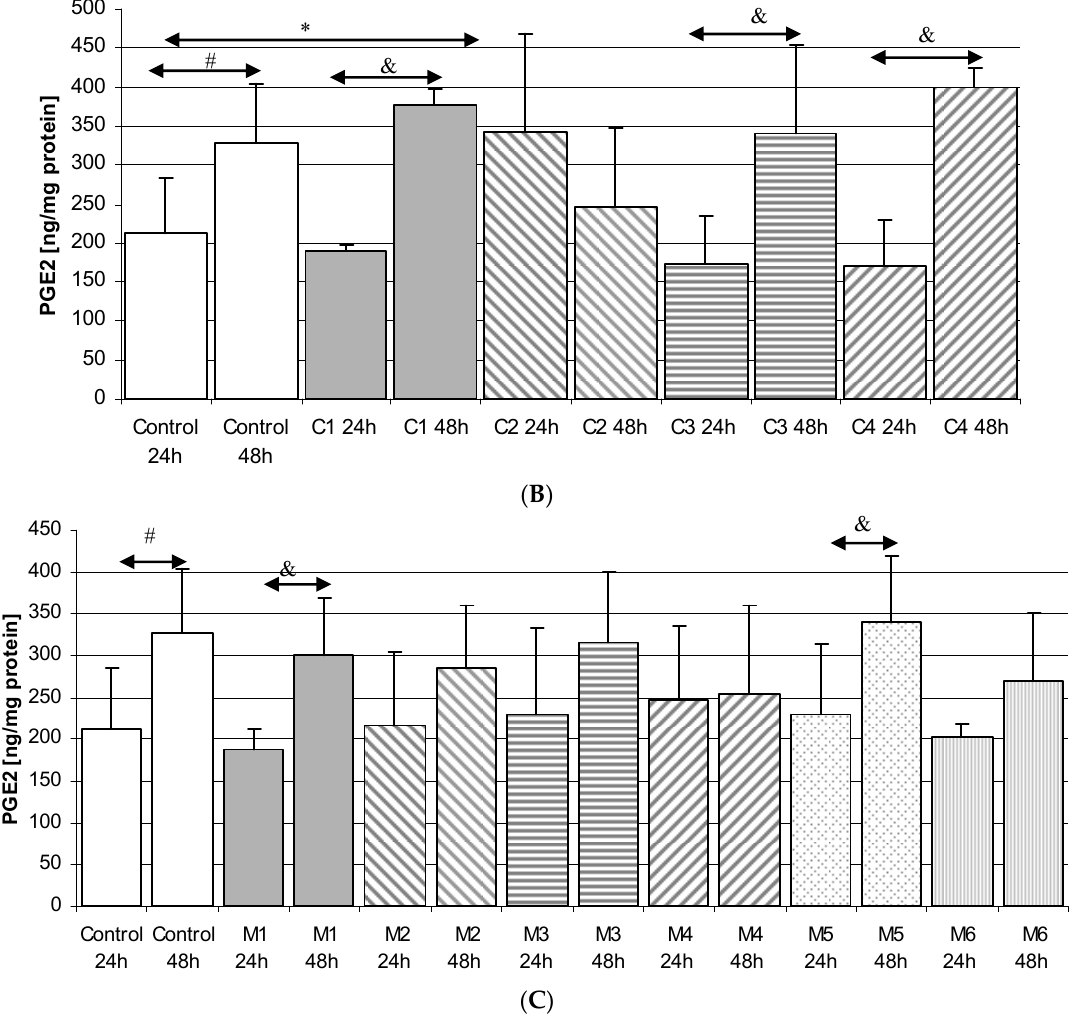
Figure 3. The levels of prostaglandin E 2 (PGE 2 ) in macrophages cultured with various plates and dedicated screws used for the surgical treatment of condylar fractures. Macrophages were cultured for 24 h and 48 h in RPMI medium with 10% FBS with various plates and dedicated screws: ( A ) SYNTES (S1, S2, S3); ( B ) MARTIN (C1, C2, C3, C4); ( C ) MEDARTIS (M1, M2, M3, M4, M5, M6); for details see Table 1). After incubation, the cells were harvested by scraping and PGE 2 concentration was measured by ELISA. Experiments were conducted as six separate assays, each assay in three replicates, ( n = 18). * Statistically significant differences in comparison to control 24 h ( p ≤ 0.05), # Statistically significant differences in comparison to control 48 h ( p ≤ 0.05), & Statistically significant differences in comparison to appropriate plate 24 h ( p ≤ 0.05). Control cells were incubated in RPMI medium with 10% FBS.